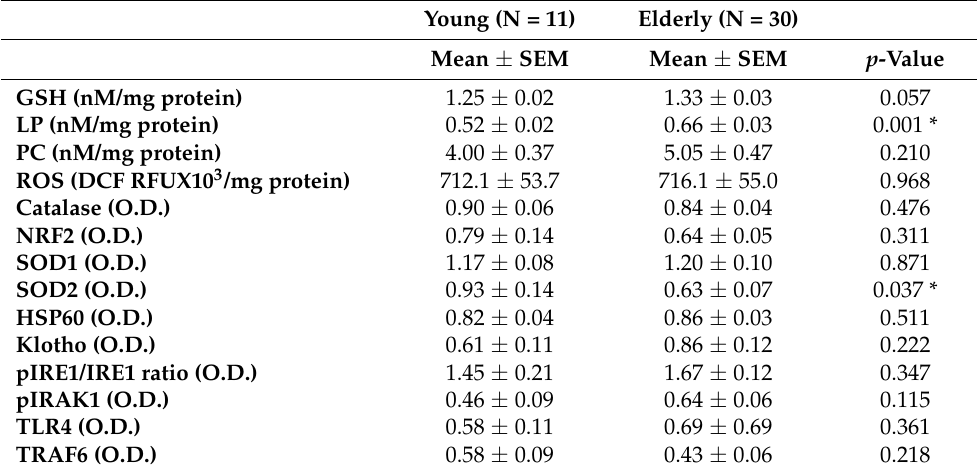
Table 3. Oxidative status, UPR IRE1 pathway activation, and inflammatory response at baseline in young and elderly